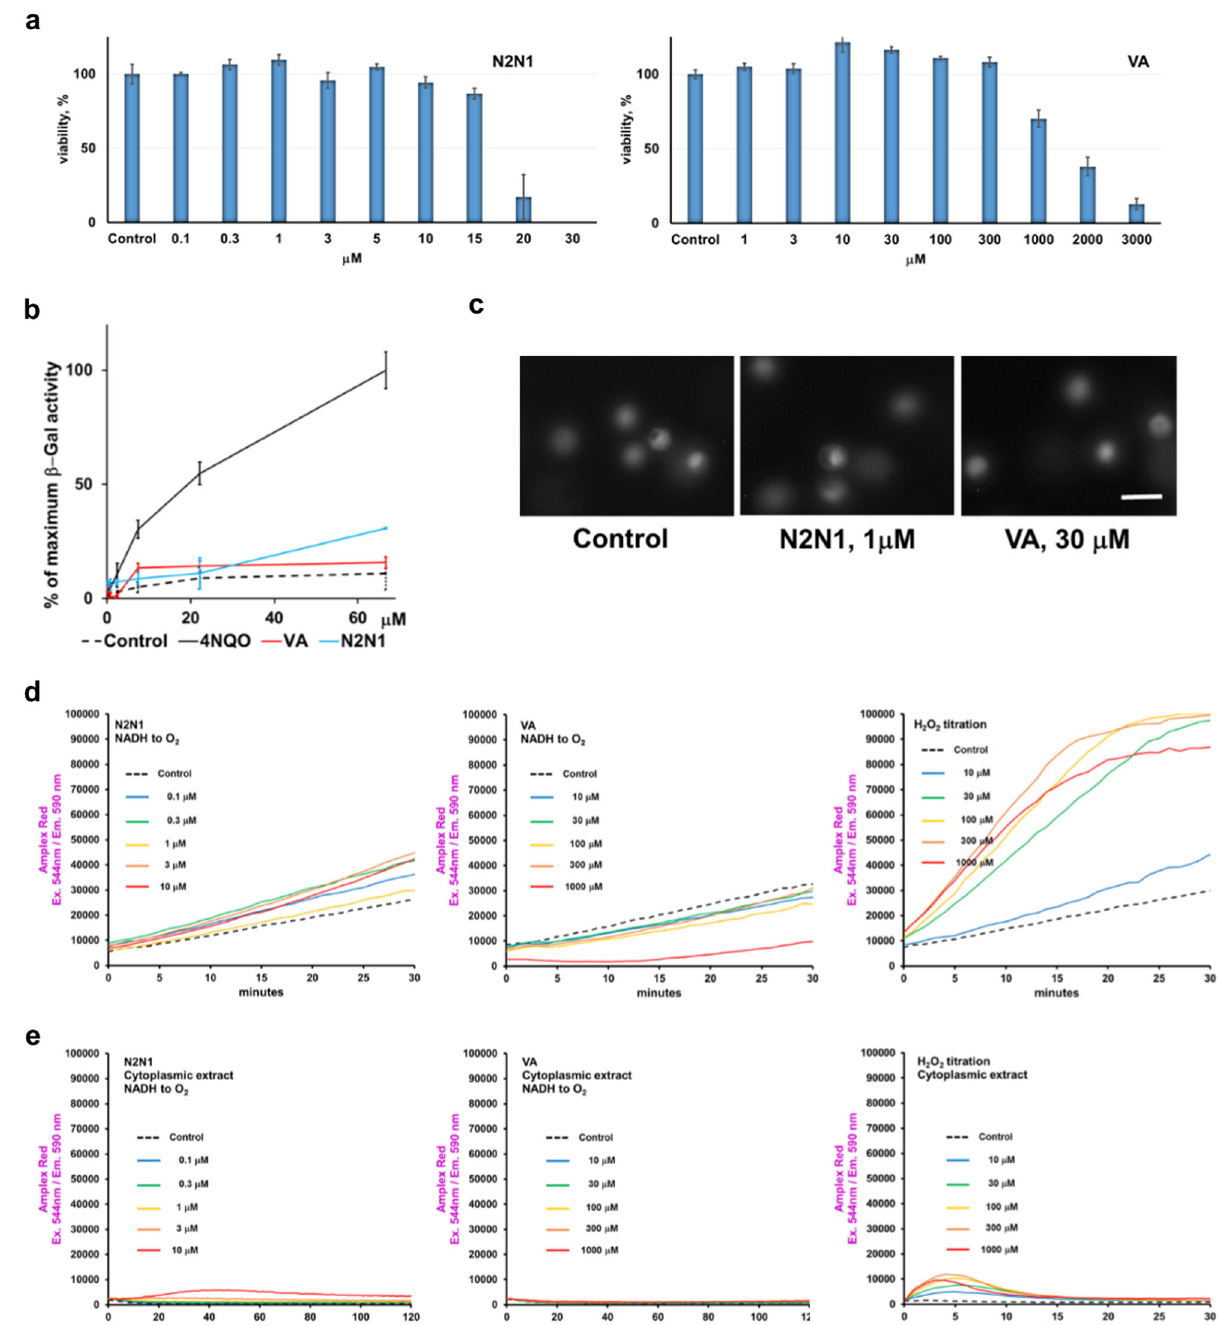
Fig. 2 The evaluation of cellular toxicity, genotoxicity and ROS generation of N2N1 and VA. a The toxicity of N2N1 and VA was not observed for the concentrations used for the anti-aging studies (VA, 30 μ M; N2N1, 1 μ M). Much higher concentrations were tolerable by the NHDF suggesting very broad therapeutic index. Results shown are mean ± standard deviation calculated from three independent experiments (three wells per treatment in 96-well plate). b Genotoxic effect of VA and N2N1 were evaluated in standard Ames assay. Both VA and N2N1 did not cause any statistically signi fi cant DNA damage detectable by the assay. 4NQO (4-Nitroquinoline 1-oxide) was used as a positive control. Results shown are mean ± standard deviation calculated from three independent experiments (three wells per treatment in 96-well plate). c Comet assay did not show any difference between control cells and cells treated with different concentrations of N2N1 or VA. Microphotographs of control, N2N1 (1 μ M) or VA (30 μ M) are shown. Scale bar: 10 μ m. NHDF were treated with the drugs for 10 days. Average size of the “ comets ” and standard deviation was calculated based on measurement of at least 25 ethidium bromide positive objects and shown in Table S2. d Generation of ROS was evaluated by Amplex red assay in a reaction mixture containing tested drugs and NADH. N2N1 or VA treatment did not generated any detectable level of peroxide and corresponding increase in resoru fi n fl uorescence. VA treatment (middle plot) even slightly decreased the level of fl uorescence at 590 nm indicating possible anti-oxidant properties. The H 2 O 2 titration plot is shown on the right. e N2N1 or VA treatment did not result in generation of ROS in a reaction mixture containing cytoplasmic extract prepared from NHDF, tested drugs and NADH. The H 2 O 2 titration plot is shown on the